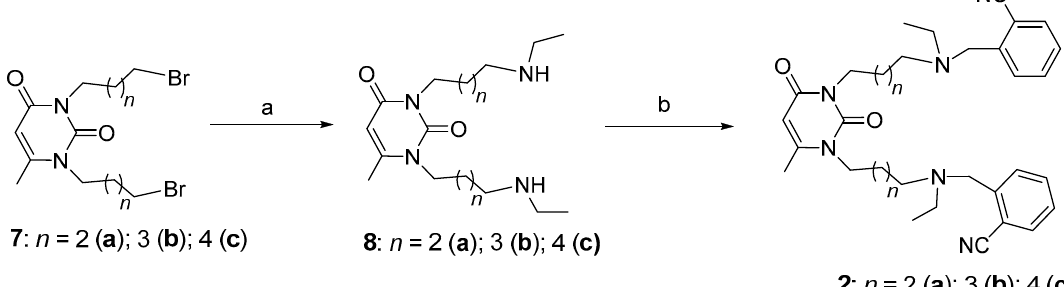
Figure 1. Structures of previous reported acetylcholinesterase (AChE) inhibitors 1a – f with 6- methyluracil, nitro-, and trifluoromethyl moieties [25] and herein reported AChE inhibitors 2a – c, 3, 4a,b with 6-methyluracil, quinazoline-2,4-dione and nitrile moieties. Numbering of pyrimidine